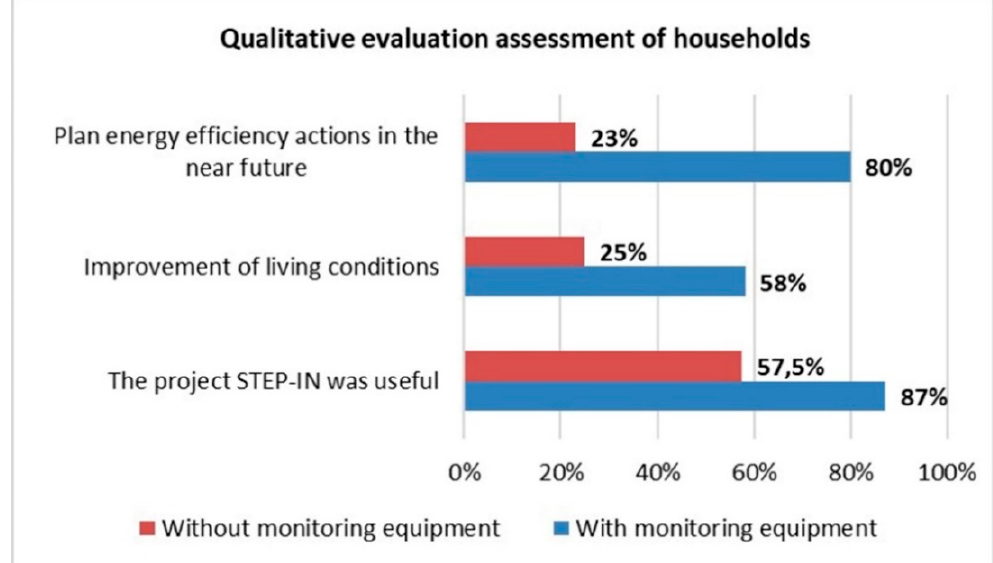
Figure 12. Qualitative evaluation assessment of households with and without equipment regarding the project